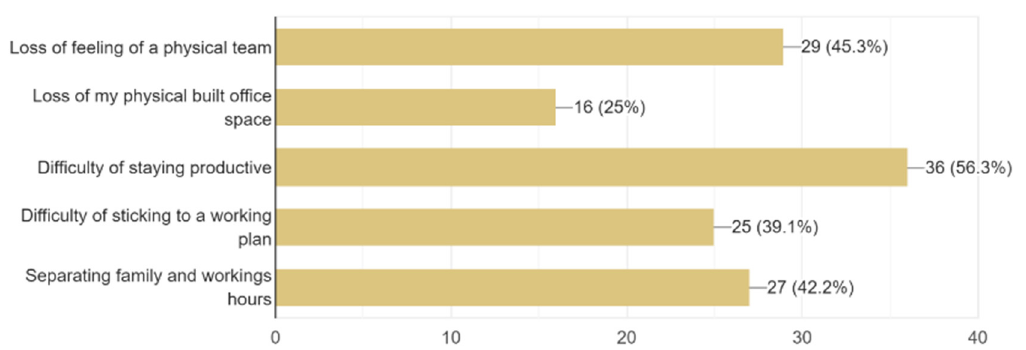
Figure 3. ( a ) Impact of the COVID-19 pandemic on RRs’ employment; ( b ) impact of the COVID-19 pandemic on RRs’ health. Source: online survey that took place between December 2020 and March 2021. N: 64.